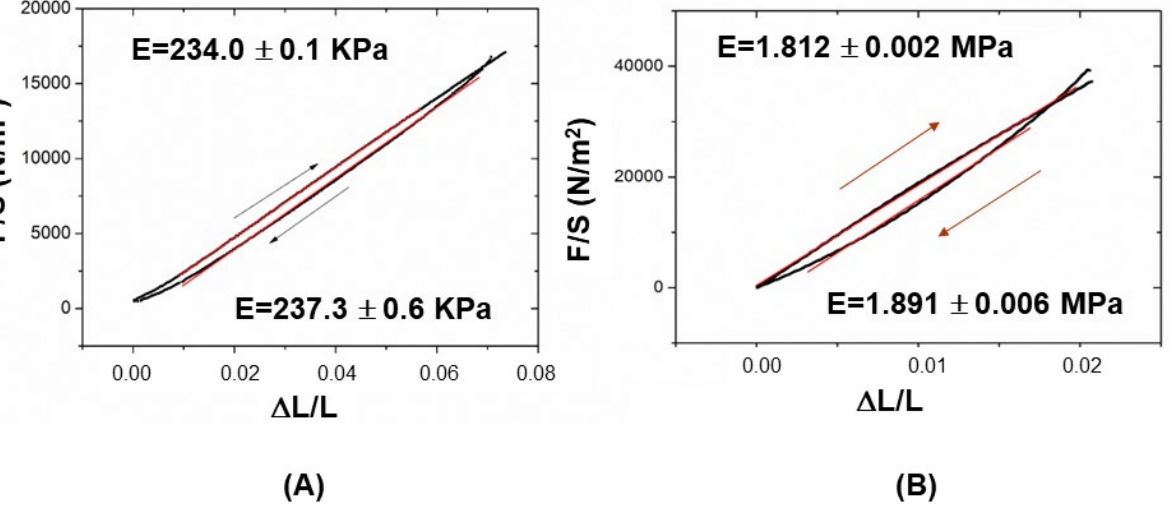
Figure 8. Elastic modulus of monodomain SC-LCE 1 ( A ) and SC-LCE 2 ( B ) samples measured at room temperature. Stretching and compression were applied at a controlled value of the force. Black curve corresponds to experimental data while red curves are linear fitting functions, y = Ex + b.